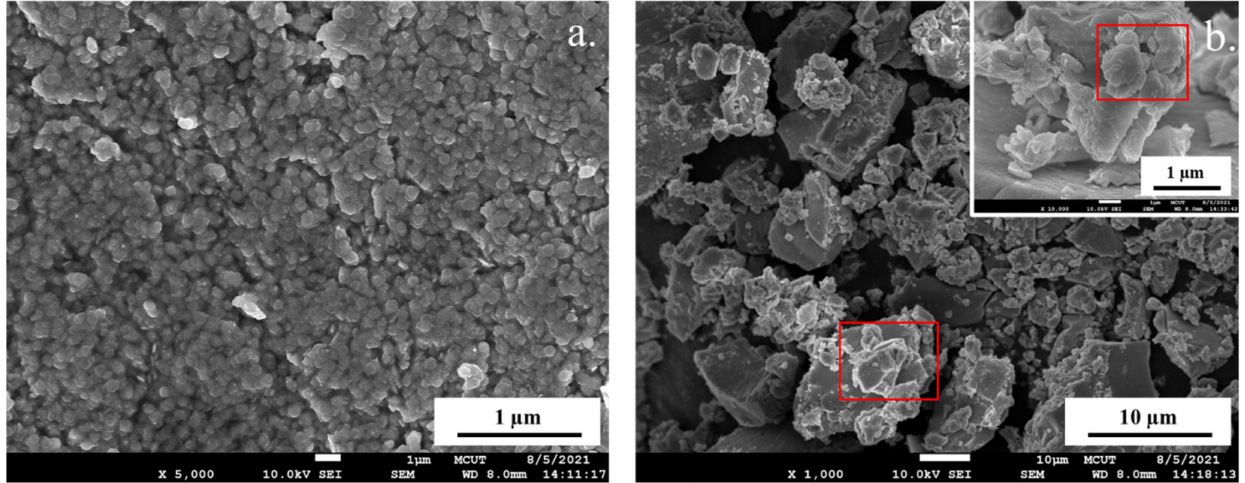
Figure 4. FESEM images of ( a ) PNP and ( b ) PNC powders.